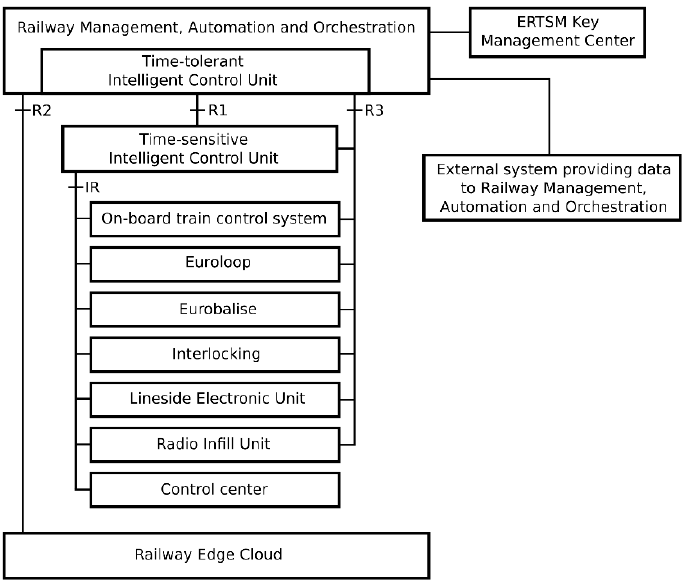
Figure 1. High-level view of the logical architecture of the intelligent railway network.